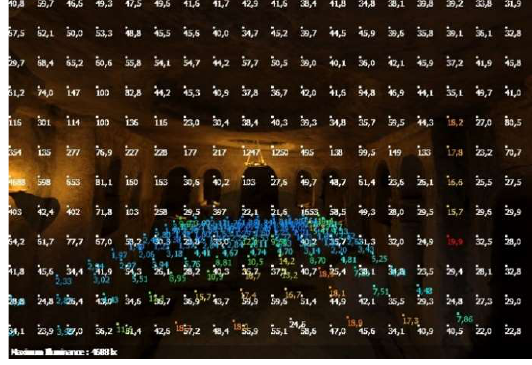
Figure 20: Luminance distribution-h 8 del